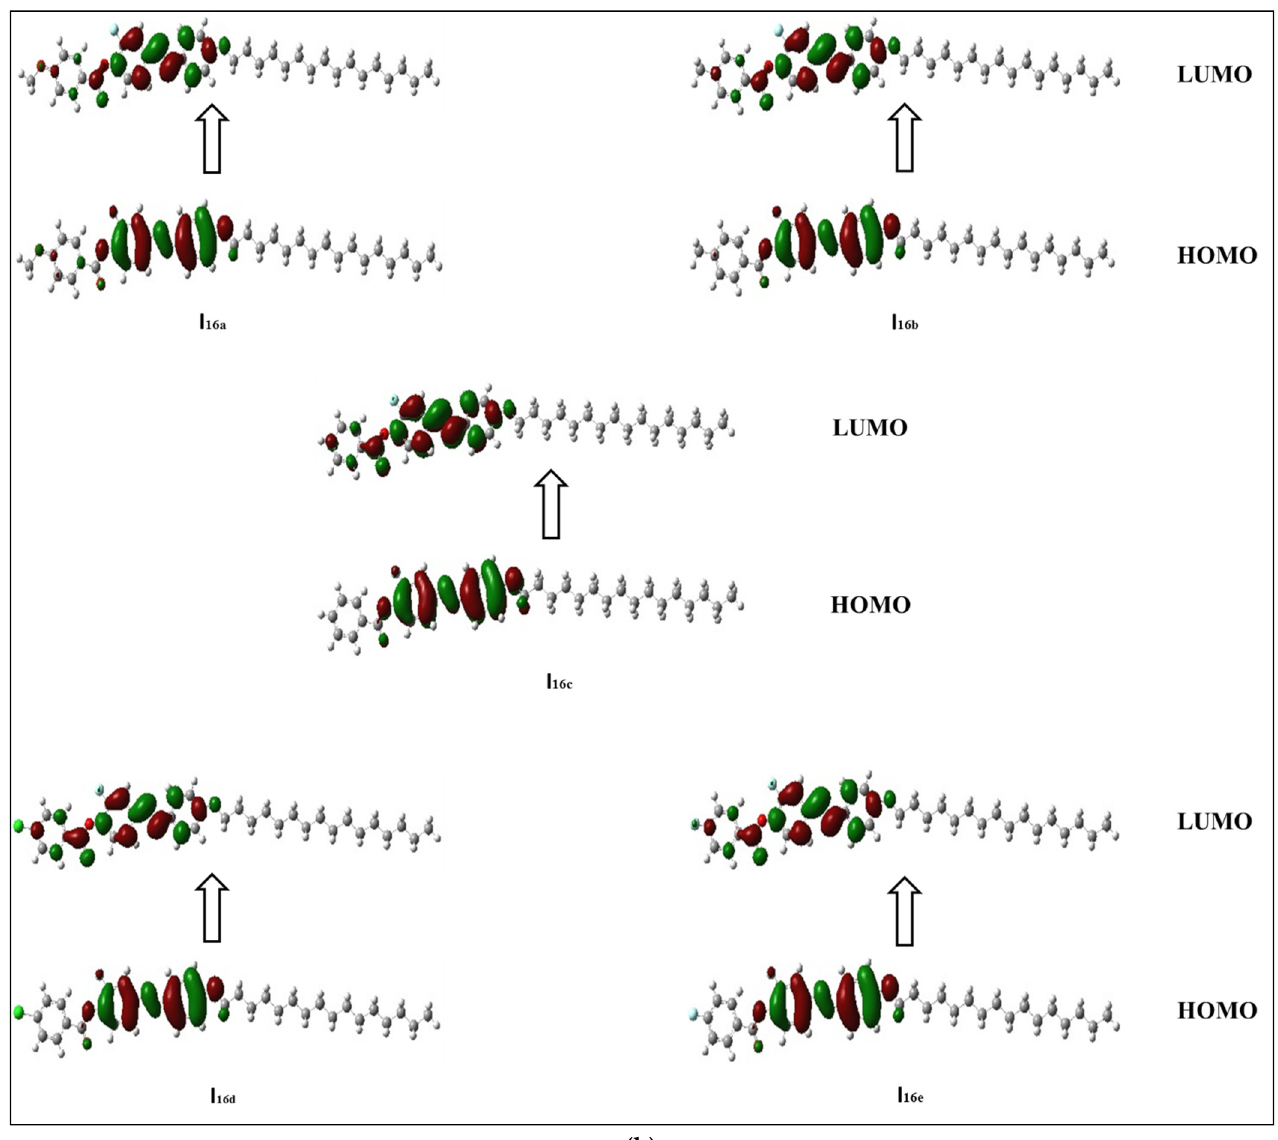
Figure 5. Estimated FMOs for of the synthesized analogues sets ( a ) I8 x and ( b ) I16 x .